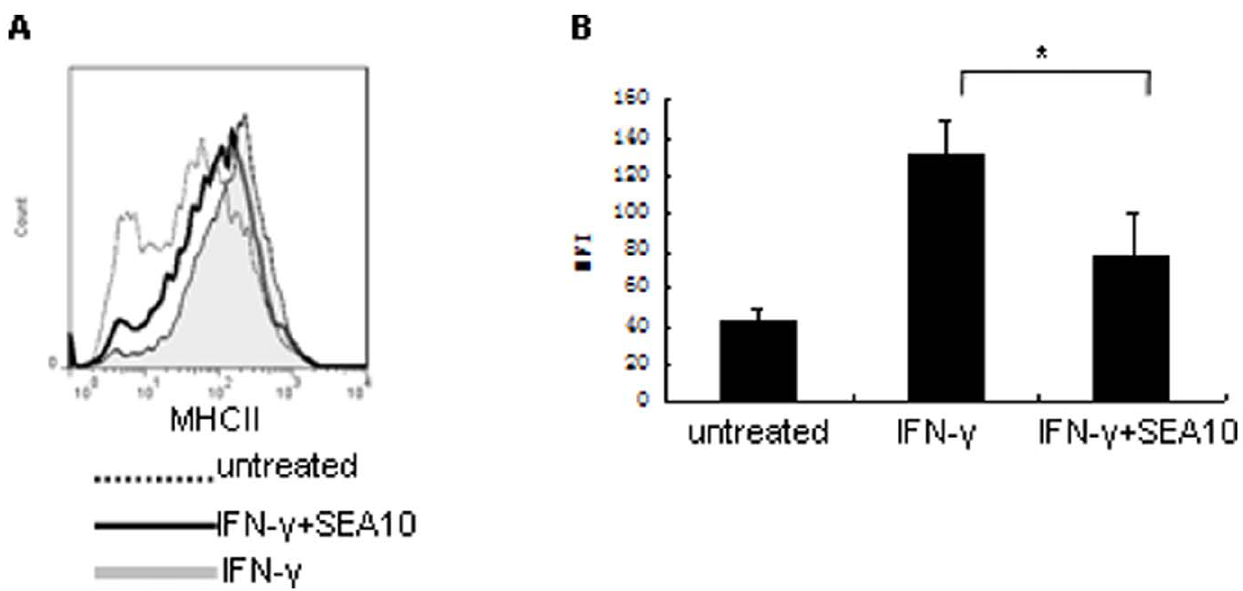
Figure 5. SEA attenuated MHC class II expression in primary macrophages. (A) Flow cytometric analysis of MHC class II expression in primary mouse peritoneal macrophages stimulated with 10 ng/ml IFN- c (R&D) (shaded histogram), 10 m g/ml of SEA (SEA10, pretreated with endotoxin removing gel) and IFN- c simultaneously (open histogram with thick line) and untreated cells (open histogram with dotted line). (B) Histogram showing the MFI of MHC class II expression in primary mouse peritoneal macrophages stimulated with IFN- c , 10 m g/ml of SEA (SEA10, pretreated with endotoxin removing gel) and IFN- c simultaneously (IFN- c + SEA10) and cells cultured with medium alone (untreated). (* P , 0.05).